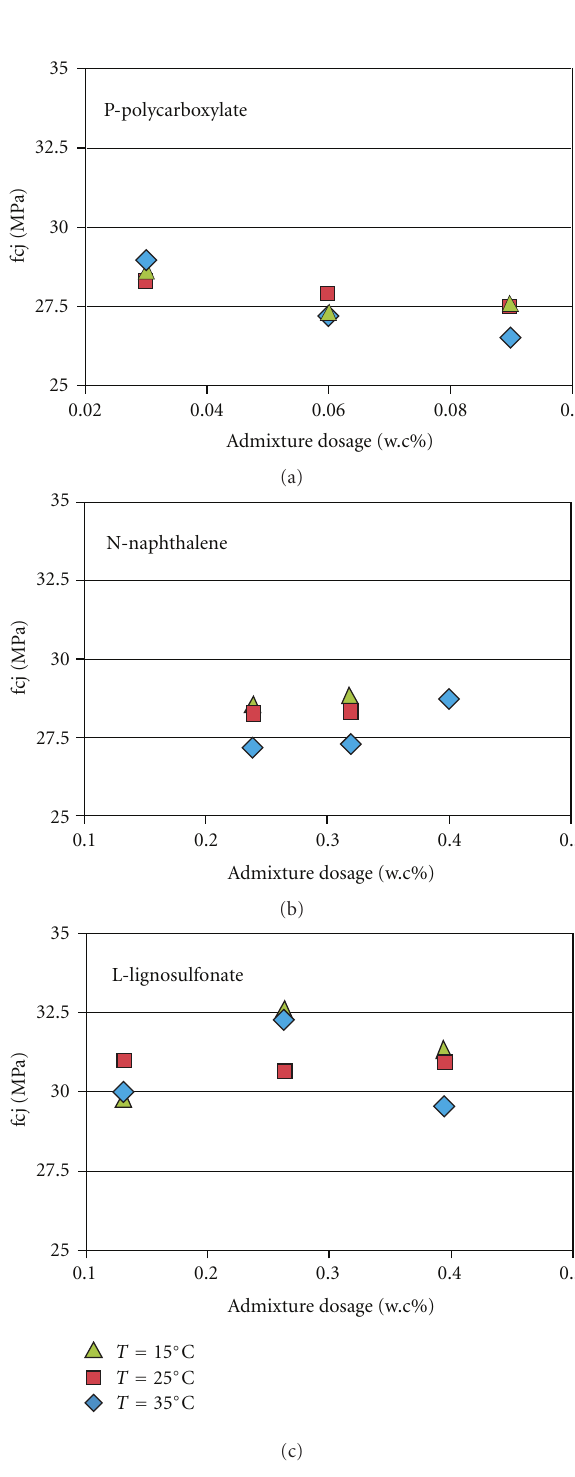
Figure 12: E ff ect of temperature variation and admixture dosage on compressive